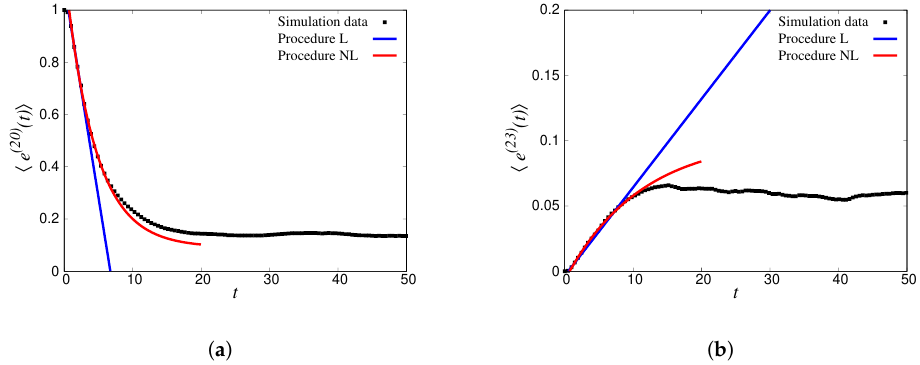
Figure 15. ( a ) Decaying binned total energy response of the initially agitated Bin 20 for k ins = 1.86 with the fits following the L and NL procedures. ( b ) Increasing binned total energy response of Bin 23 receiving energy with the fits following the L and NL procedures. Only times from 2 ∆ t to 8 ∆ t were used for the linear fit and from 2 ∆ t to 18 ∆ t for the nonlinear fit, with ∆ t = 1. Note that in all cases, the fits were supposed to only catch the short time behavior, incrementally, not the steady-state limit.